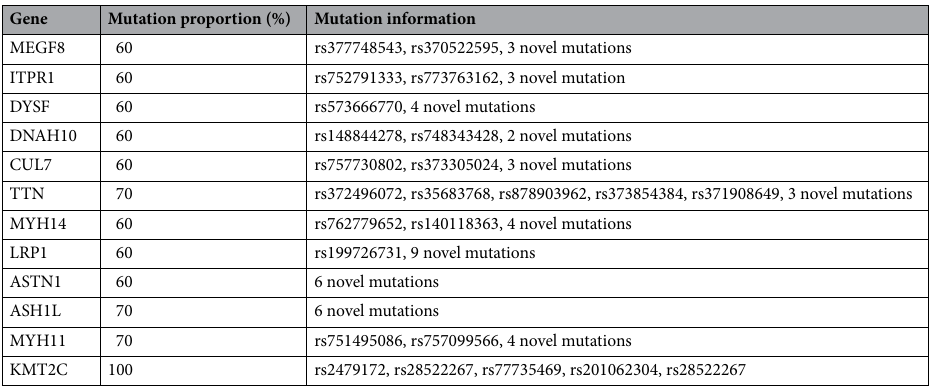
Table 2. Mutations of mutated genes in at least 6 patients.